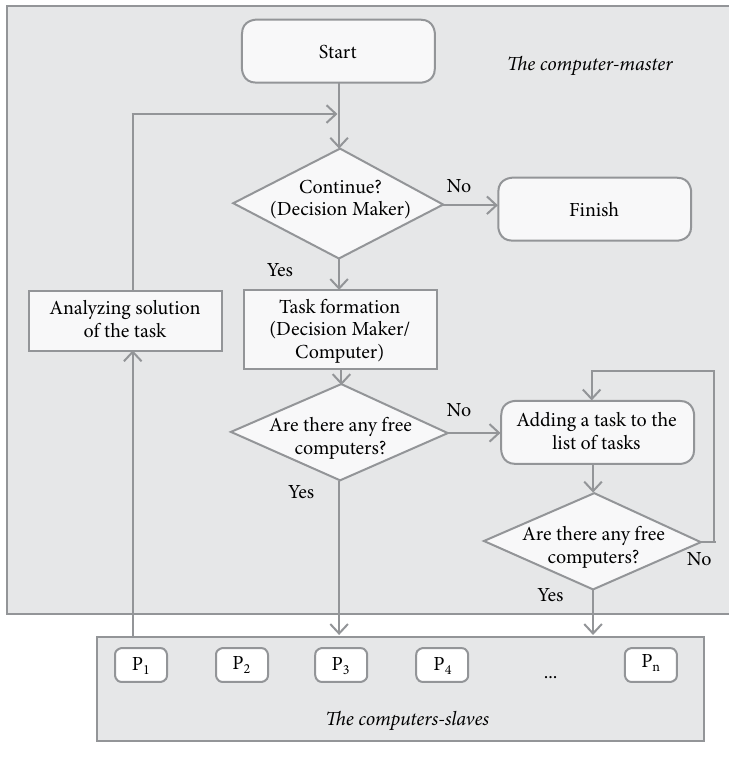
Fig. 3. A scheme of solving the optimization